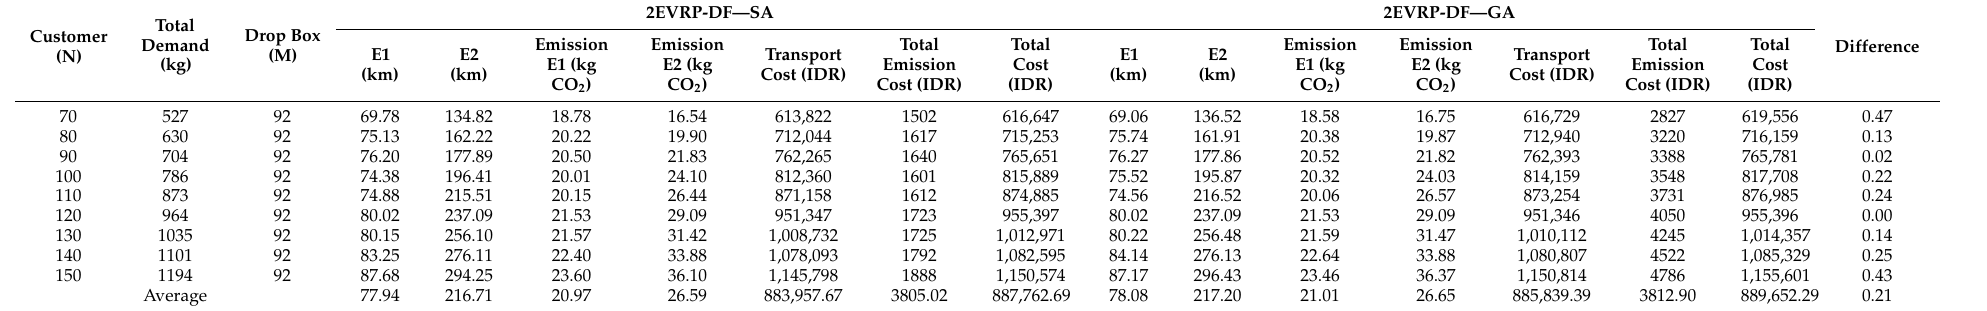
Table 5. Comparison of total objective between SA and GA.